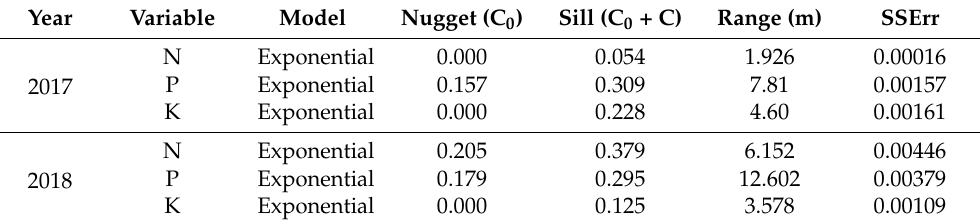
Table 1. Parameters of the fitted models for semivariograms of the soil nutrients. The Nugget (C 0 ) indicates the variance not explained by the model. The Sill (C 0 + C) represents the maximum semivariance found between a pair of sample points. The Range (m) is the distance at which the semivariance no longer increases (i.e., the distance at which soil nutrients are spatially independent among samples). The SSErr indicates the squared sum of errors associated to each model fit. Year Variable Model Nugget (C 0 ) Sill (C 0 + C) Range (m) SSErr N Exponential